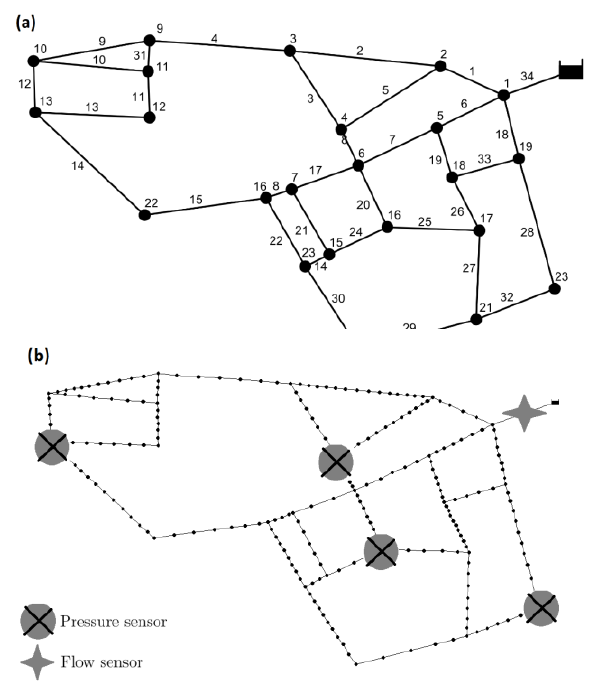
Figure 2. Apulian network: ( a ) model network where the calibration processes are launched (number of nodes = 23, number of pipes = 34); ( b ) reference network where the measurements are taken (number of nodes = 238, number of pipes = 268).